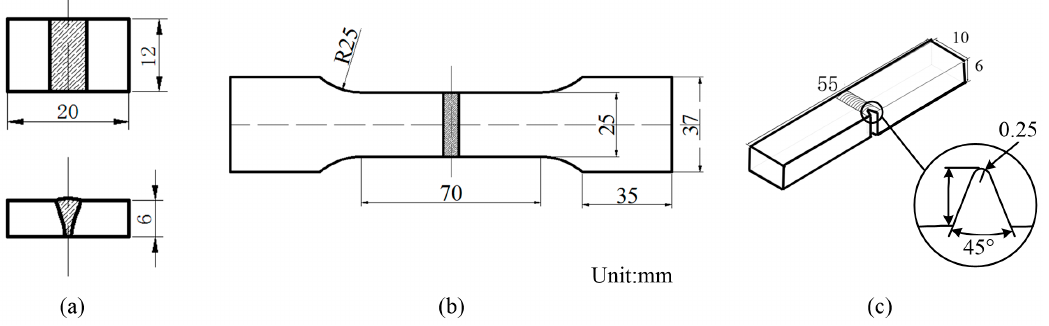
Figure 2. The dimensions of ( a ) the transverse sample; ( b ) the tensile sample; and ( c ) impact sample.